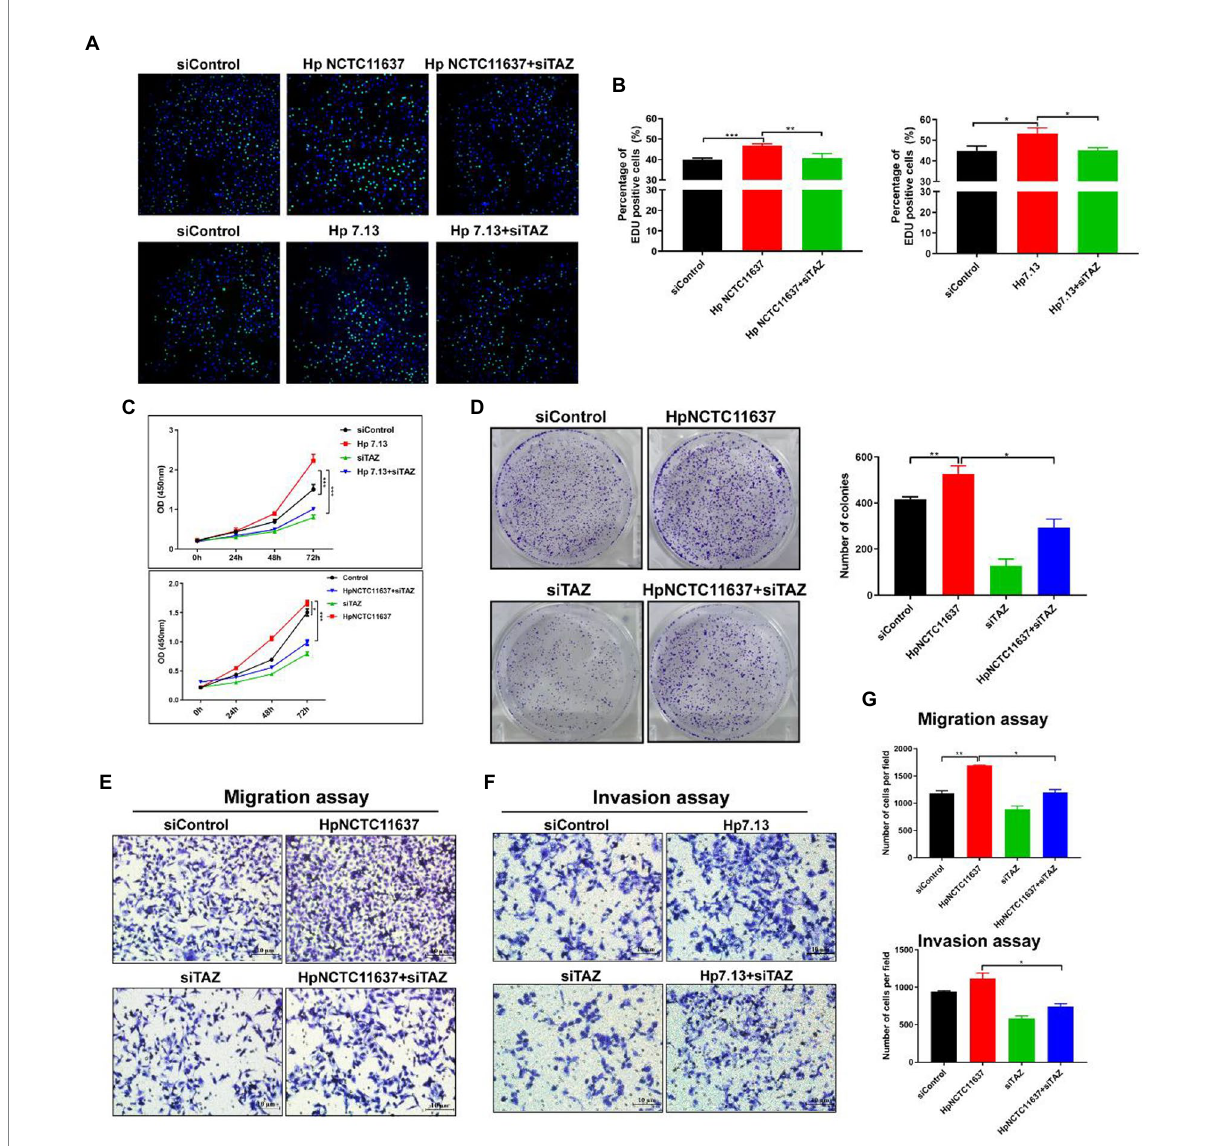
FIGURE 3 TAZ knockdown significantly inhibited H. pylori infection-induced cell proliferation, invasion and migration. (A) EdU assay for cell proliferation in AGS cells following infection with H. pylori (MOI = 100) and transfection with TAZ siRNA. Representative confocal images of EdU staining. (B) Quantification of the percentage of EdU-positive cells. (C) CCK8 viability assay for cell proliferation in AGS cells treated with H. pylori alone or in combination with TAZ siRNA. (D) Colony formation assay for the assessment of cell survival in the groups treated as described above. (E–G) Transwell migration and invasion assays were performed in the groups treated as described above. *p < 0.05, **p < 0.01, ***p <